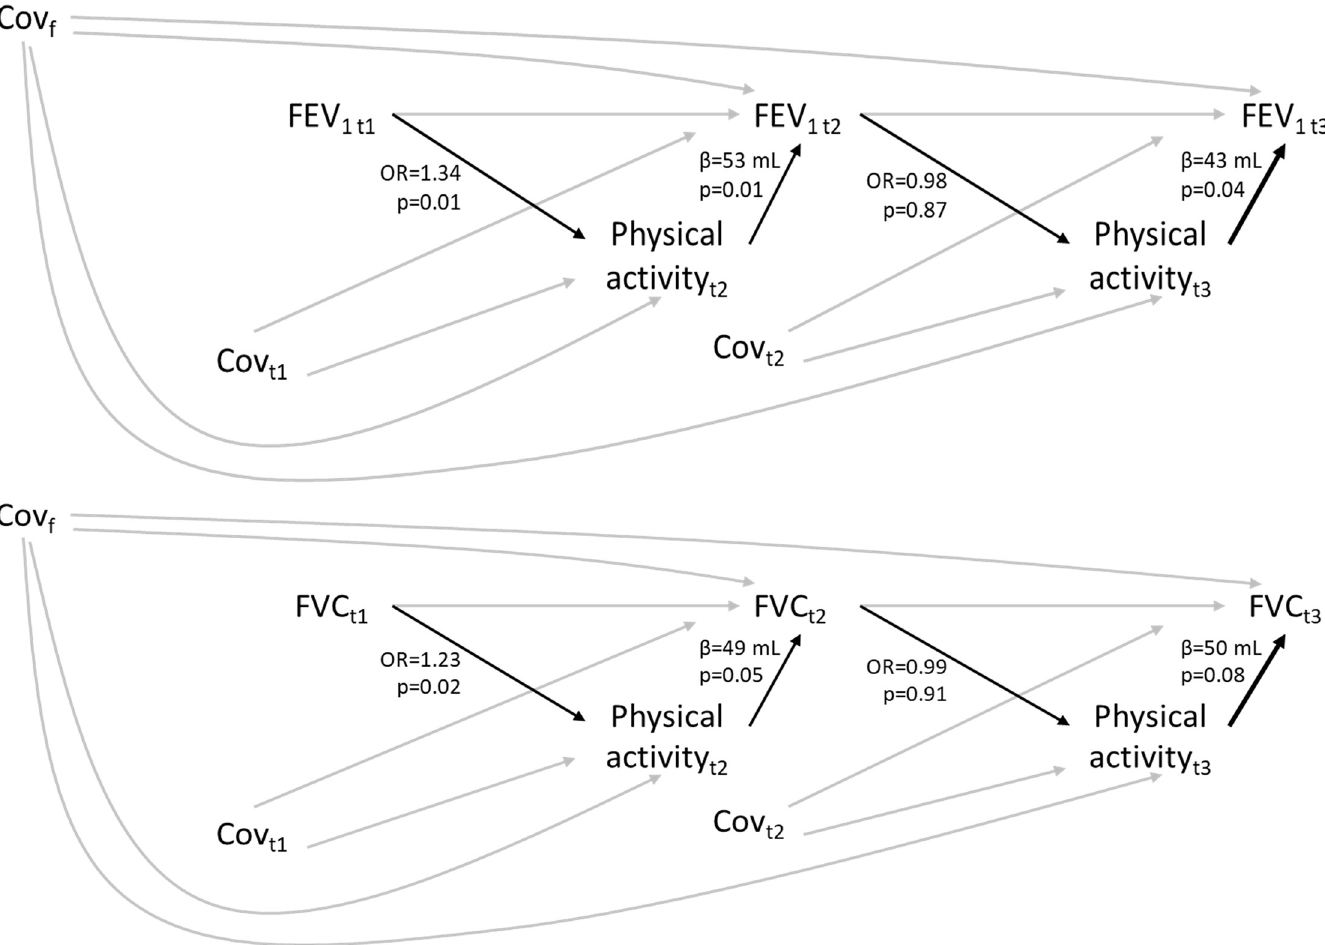
Fig 2. Associations of physical activity with lung function over time estimated using SEMs in the ECRHS cohort. Cov t (time-varying confounders): number of pack-years smoked, passive smoking exposure, weight. Cov f (time-fixed confounders): sex, education, age, age-squared, height, occupation, AHEI-2010 score, respiratory infection in childhood, centre. NB: The inclusion of BMI (instead of weight), menopausal status (in addition to age and age-squared), and occupational exposures compromised statistical power without substantially altering the results, thus they were not considered as covariates in the final models. β : difference in the expected lung function measure comparing active versus non-active individuals. OR: odds ratio comparing the risk of being active versus non-active for each 500 mL increase in lung function measures.